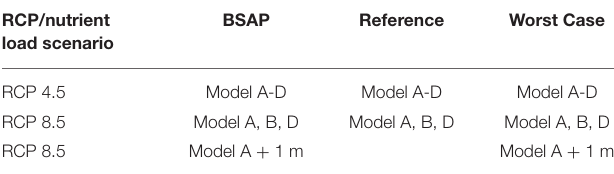
TABLE 2 | List of experiments (for details see